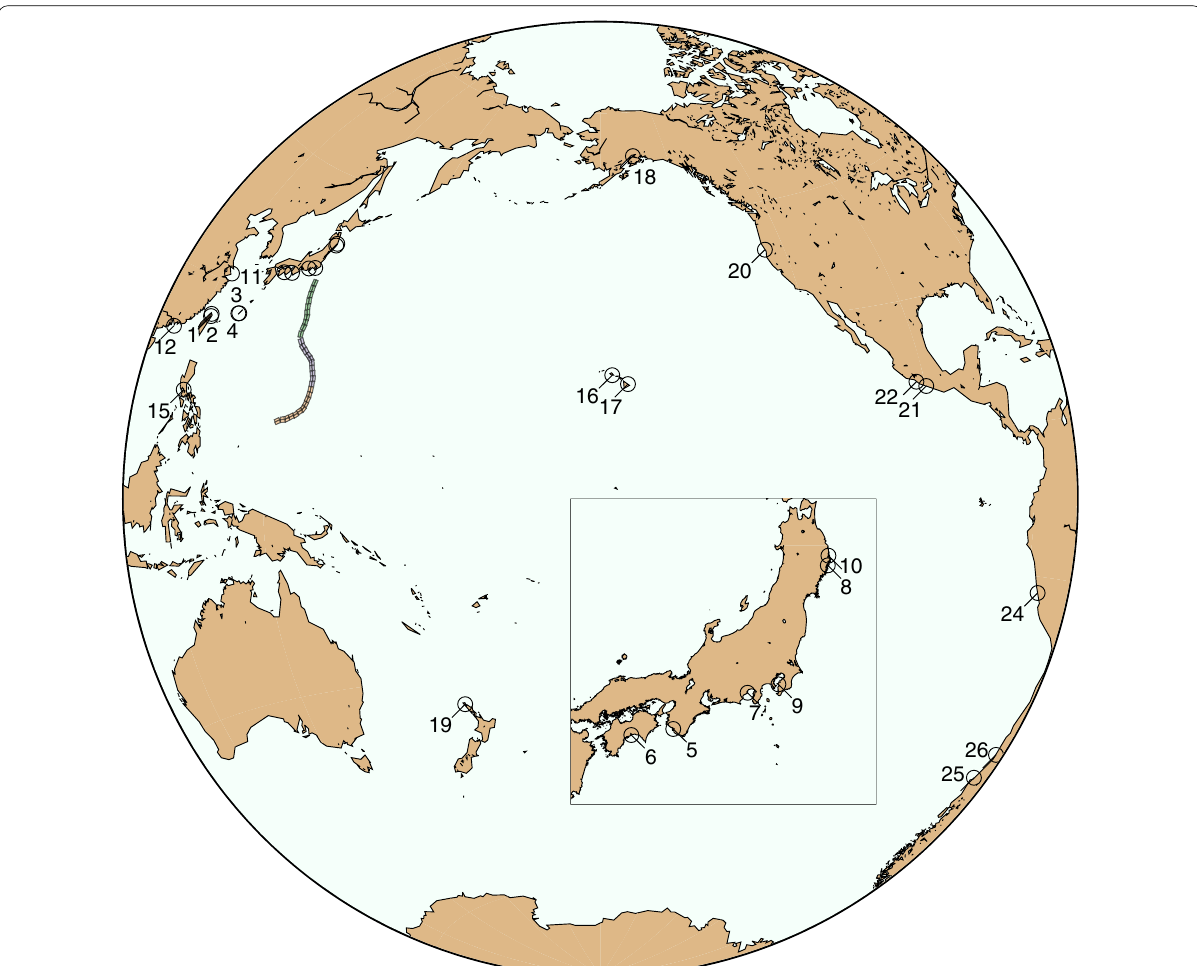
Fig. 2 Gauge locations from Table 1. Inset map shows the location of gauges along the east coast of Japan. Rectangles represent the location of the Izu–Bonin–Mariana fault segments shown in Fig.